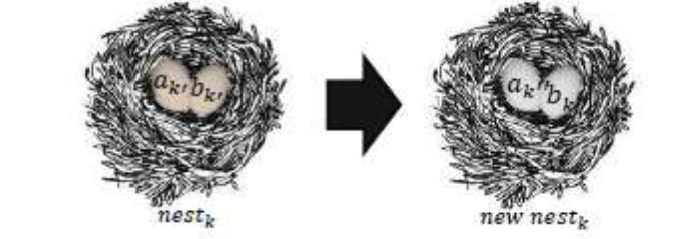
Figure 7. Building of New Nest Cuckoo Search based Clustering